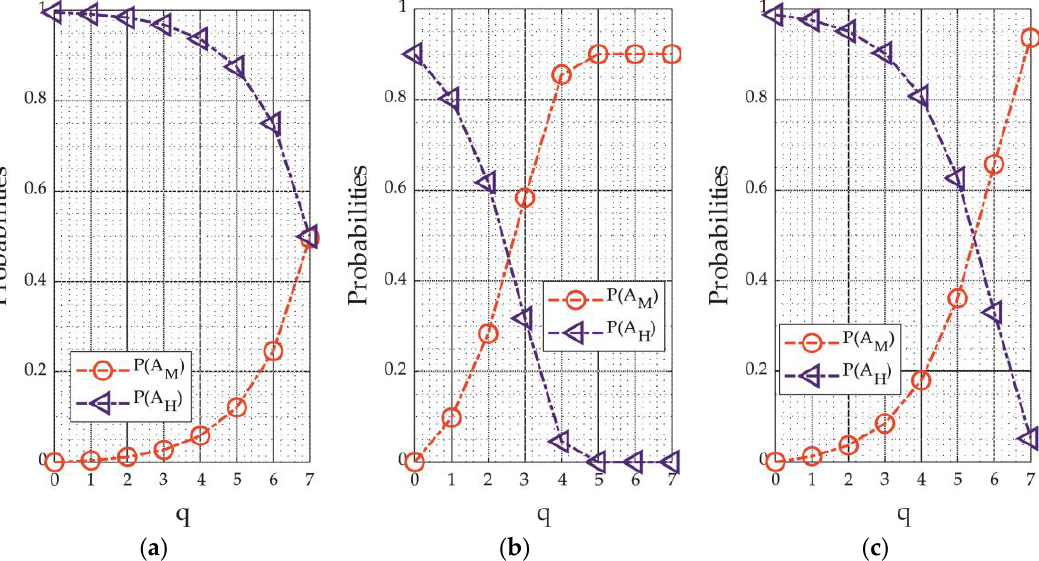
Figure 11. P ( A M ) and P ( A H ) for ( a ) the uniform distribution and the half-normal distribution in the cases ( b ) σ = 2048 and ( c ) σ = 16,384.